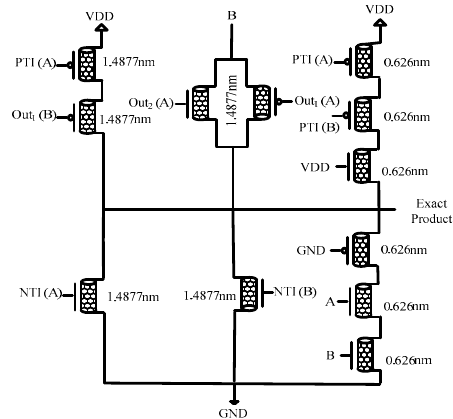
Figure 2. Schematic design of the proposed exact multiplication digit.